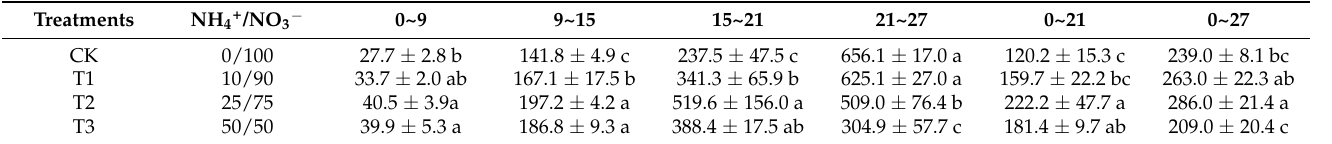
Table 2. Effects of different NH 4+ /NO 3 − ratios on the growth rate of Chinese kale (Unit: mg d − 1 plant − 1 ).